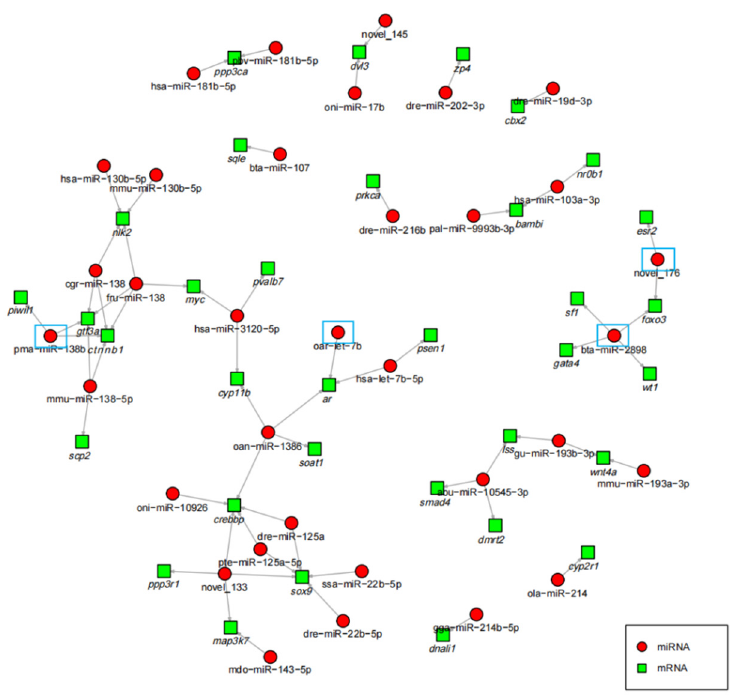
Figure 6. Differentially expressed miRNA–mRNA negative correlation network. The blue boxes are the four relatively important miRNAs, red circle represents miRNA, and green box represents target gene.